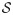
Collective decisions in a search and exploration problem: comparison between the micro and the macro dynamics.The state space of the system is presented as a ternary plot characterised by ΨU + ΨA + ΨB = 1, so that vertices correspond to fully-uncommitted or fully-committed populations. Macroscopic dynamics are indicated by trajectories and equilibrium points from the ODE model of Eq (1), parametrised according to the specific configuration. The bold yellow trajectory indicates the behaviour starting from a fully-uncommitted population (ΨU = 1). Stable equilibrium points are indicated as blue empty circles, while unstable points are indicated as green empty diamonds. The density map in the background represents the results of homogeneous multiagent simulations (1000 runs). The inset shows the success rate S for macroscopic Gillespie simulations (white bars) and multiagent simulations (homogeneous in light gray and heterogeneous in dark grey). (A) Micro-macro link for a decision problem in which the best option is also the farthest one (v
A = 0.7 < v
B = 1 and d
A = 1.5 m < d
B = 2.5 m). The magnify-glass effect allows to appreciate the close correspondence between the stable point predicted by the macroscopic model and the results from the multiagent simulations. (B) Micro-macro link for a completely symmetric decision problem (v
A = v
B = 1 and d
A = d
B = 2.5 m).